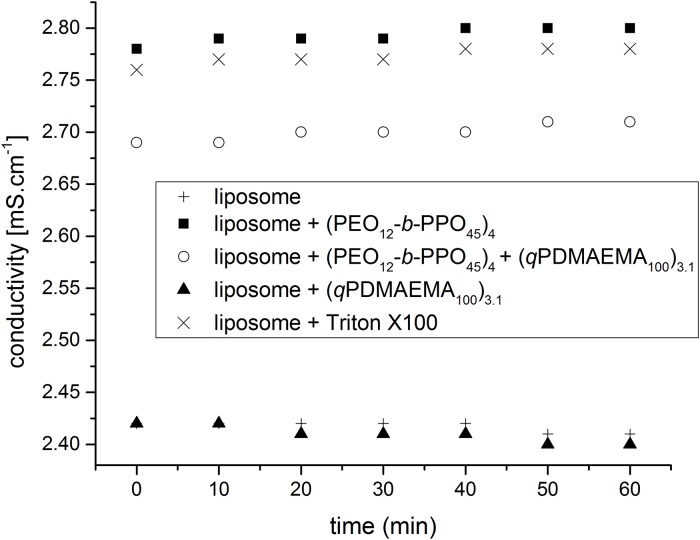
Integrity evaluation.Conductivity of solutions with liposome/polymer complexes vs. time, the liposomes are loaded with 4 mol/L NaCl and 10−2 mol/L Tris buffer. The lipid concentration is 1.1 10−3 mol/L for each sample. The concentration of PEO12-b-PPO45 arms for the respective samples is 1.8 10−4 mol/L. If present, the concentration of the positive charges of (qPDMAEMA100)3.1 is 3.31 10−4 mol/L, it corresponds to Z = 0.3. Tris Buffer pH = 7, 20°C.